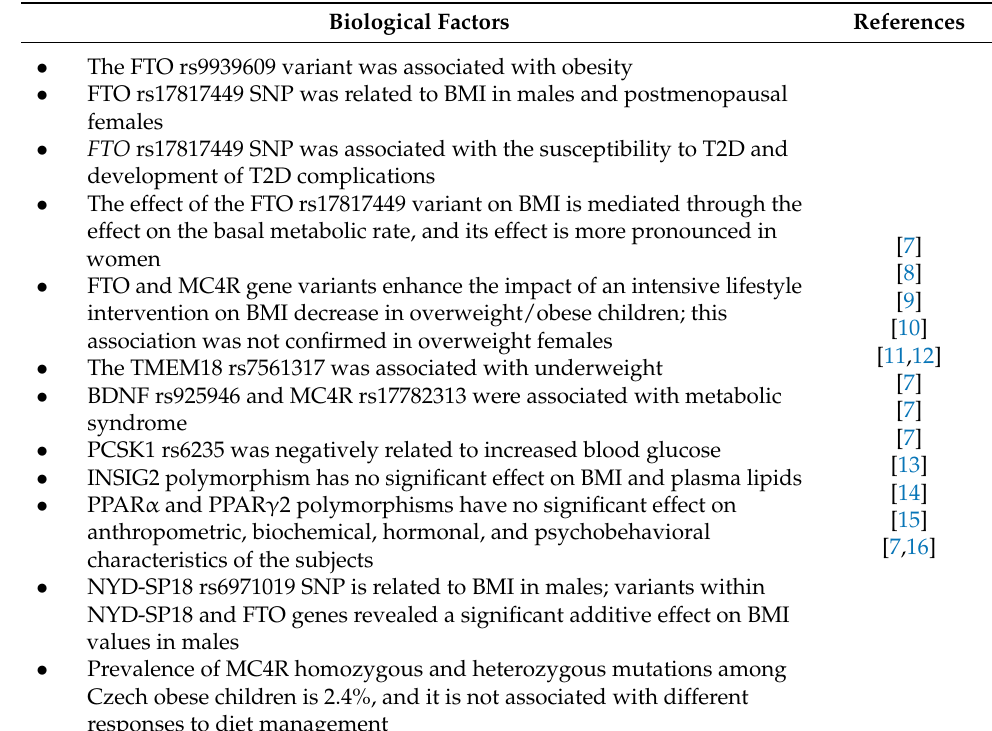
Table 1. Important biological factors for cardiometabolic risk